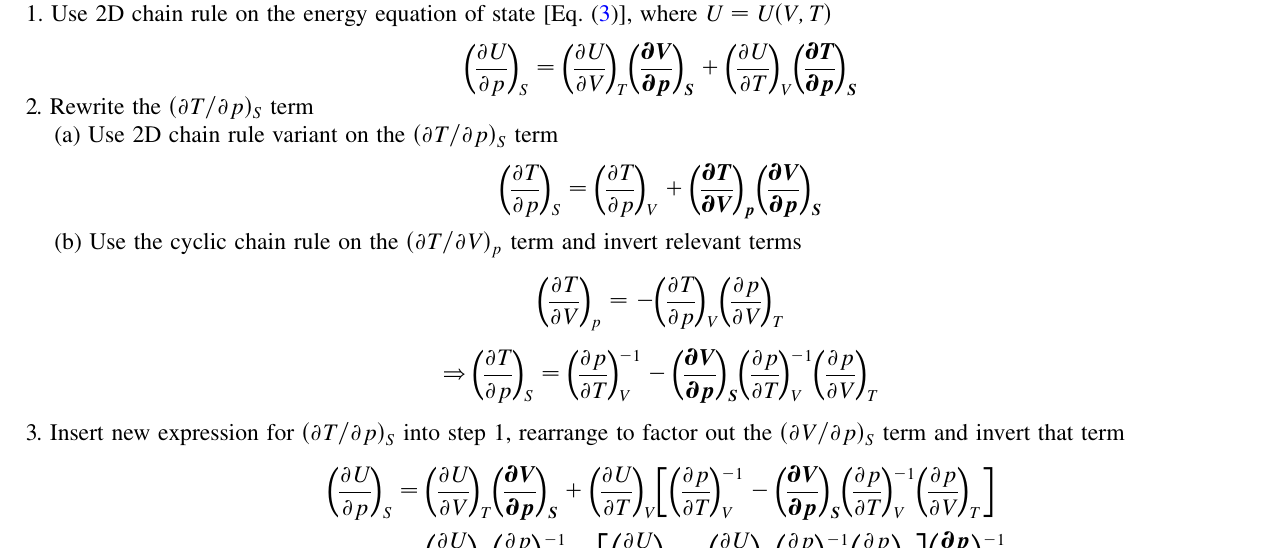
TABLE V. Idealized example of the Partial Derivatives game. Bolded partial derivatives are not ‘‘nice